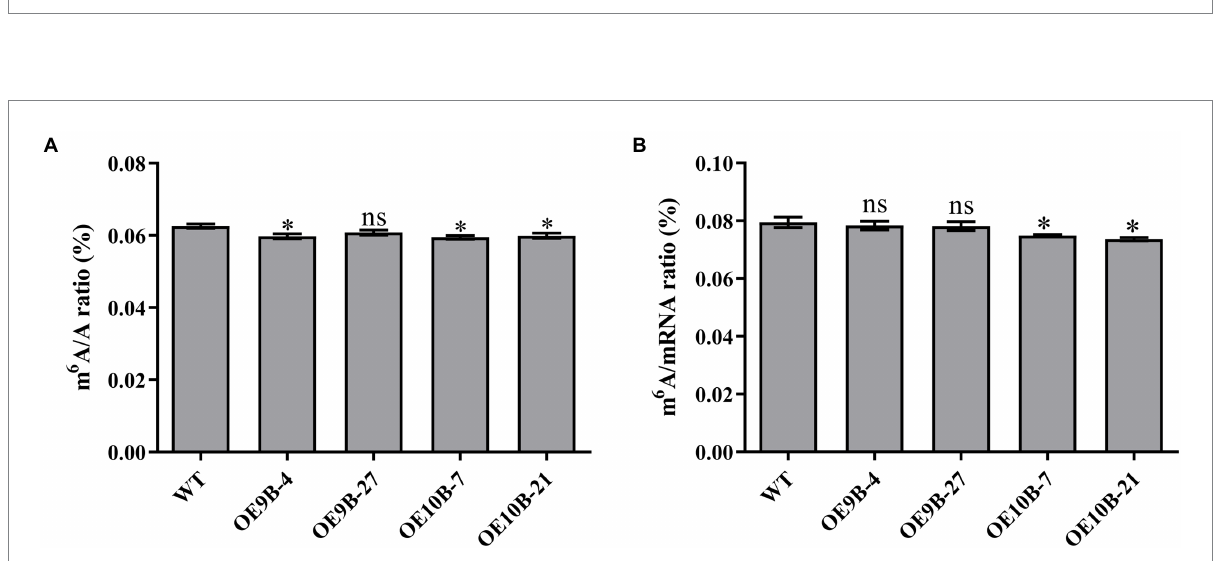
FIGURE 3 Tissue-specific expression patterns of PagALKBHs poplar 84K. The roots, stems, leaves, and stem apex of 84K poplars under normal growth conditions were collected, different tissues of at least six 84K poplar were collected as a replicate. The data represented averages ± SE of three replicates. The different letter indicated significant differences between different tissue.